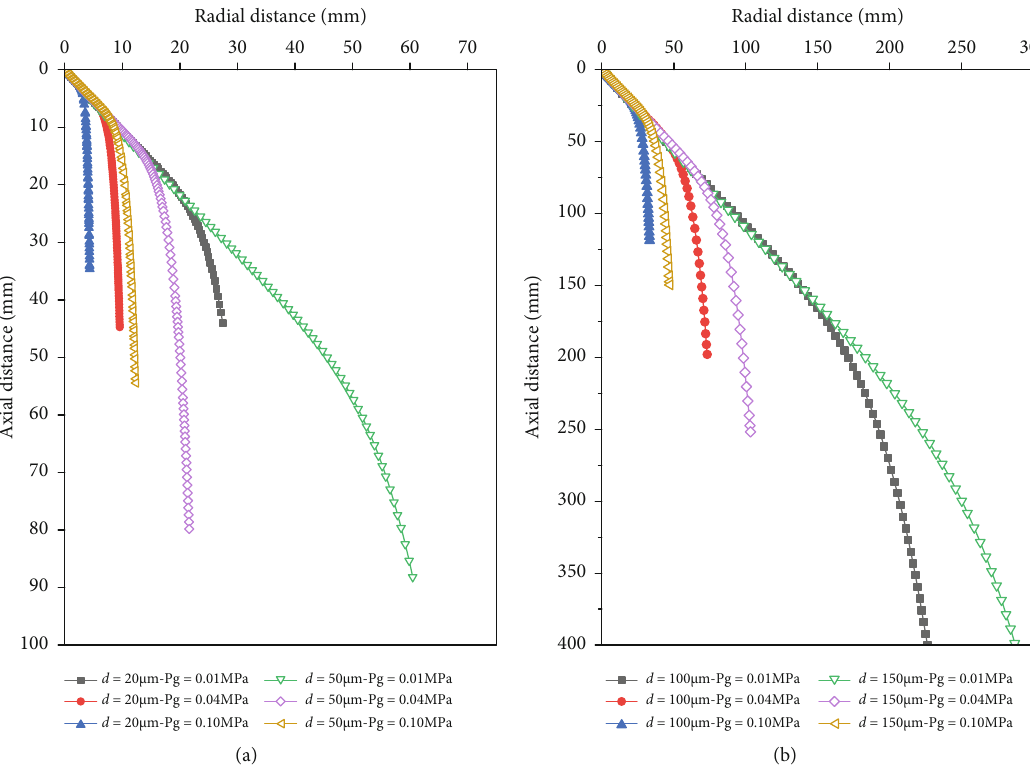
Figure 8: Trajectory of droplet with di ff erent diameters: (a) d = 20 μ m, d = 50 μ m; (b) d = 100 μ m, d = 150 μ